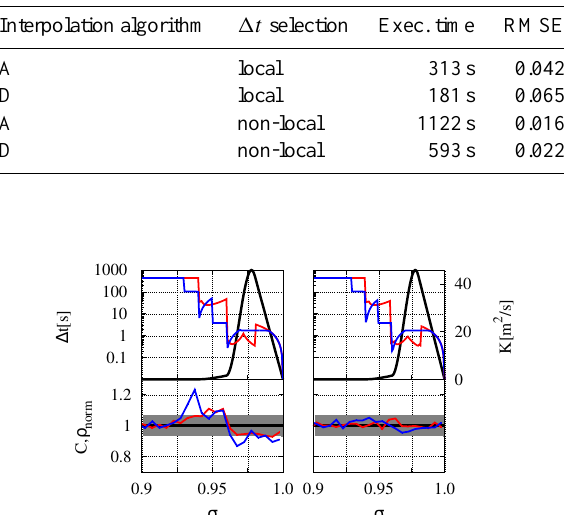
Table 3. Execution time and RMSE for experiments made with the “peaked” diffusivity distribution, varying interpolation method and 1t selection algorithm.